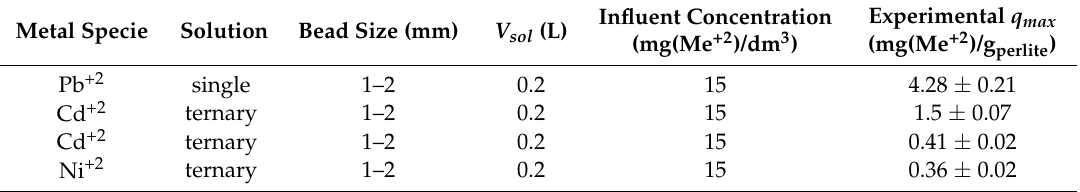
Table 1. Summary of the batch tests carried out on the perlite sorbent and experimental retention capacities. Metal Specie